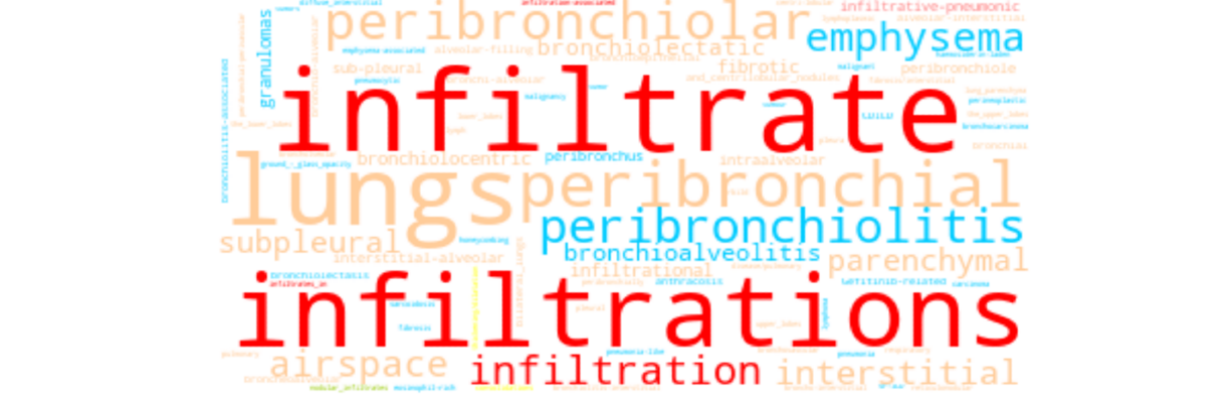
Figure 6. Word cloud depicting each returned term for “lung infiltrates.” Colors correspond to semantic class types.